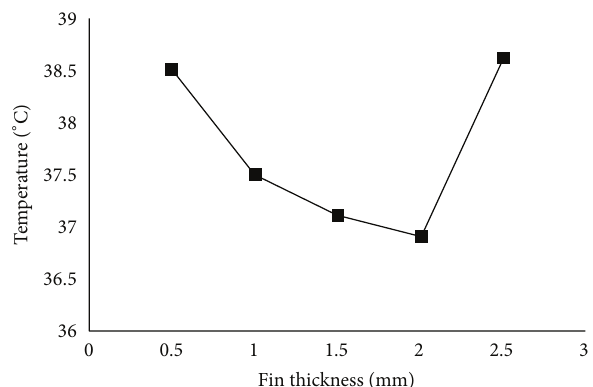
Figure 3: Relationship between the thickness of hollow fins and the highest temperature of the fins.